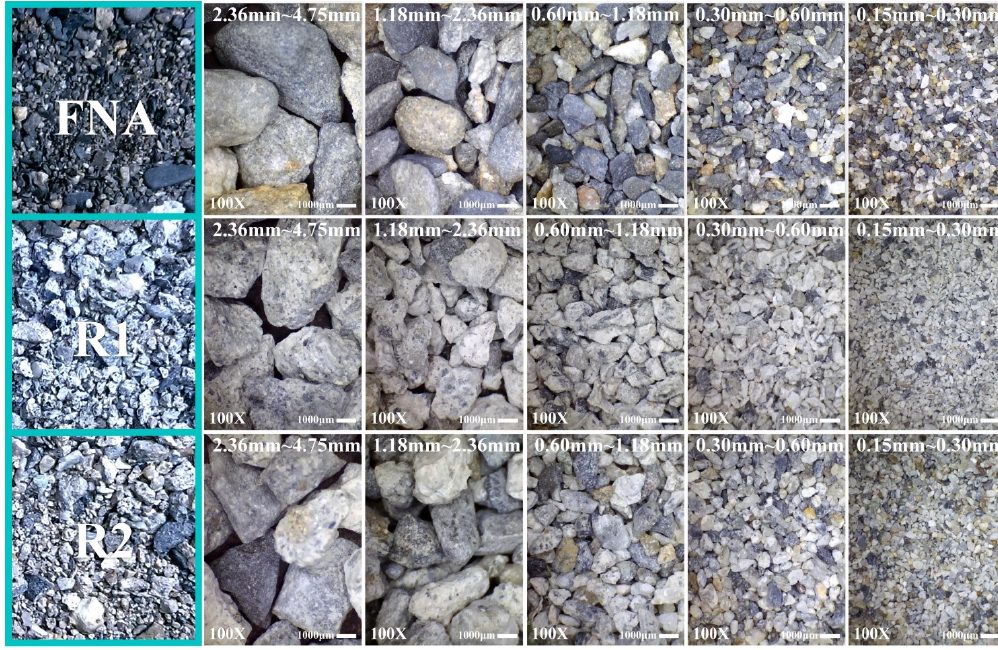
Figure 3. Comparison of appearances and particle size distributions of FNA, R1 and